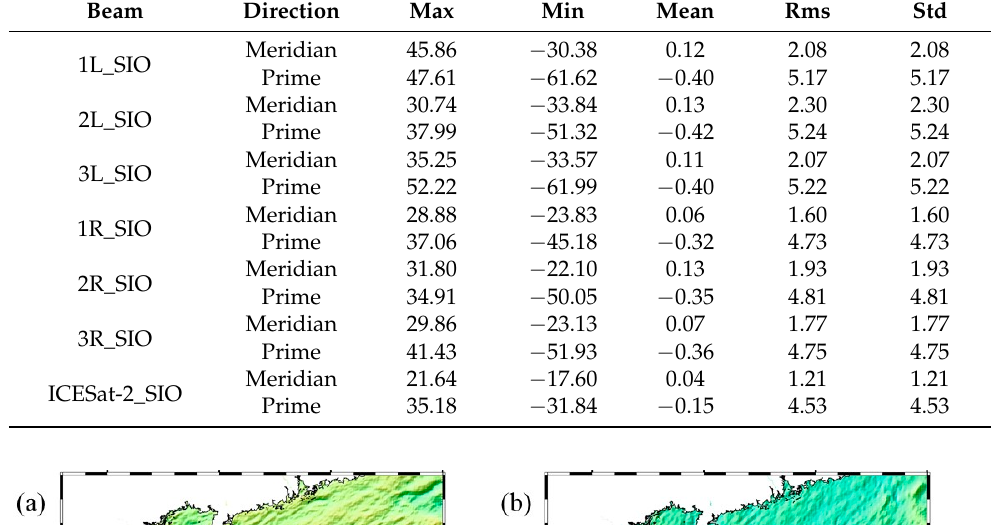
Table 11. Statistics of differences between gridded DOVs calculated by the along-beam DOVs and the SIO V31.1-DOV model (Unit: arc_sec). Beam der a search radius of 8 ′ . Therefore, the optimal search radius is selected as 8 ′ . Table 9. STD of differences between gridded DOVs calculated by the along-beam DOVs with dif- ferent search radii and the SIO V31.1_DOV model (Unit: arc_sec). Search Radius Meridian ICESat-2_SIO-DOV The 2 ′ × 2 ′ gridded DOV within the SCS is derived with the weighted least squares method from along-beam DOVs, and its directional components are shown in Figure 7. The XGM2019e_2159-DOV model and SIO V31.1-DOV model are used to verify the pre- cision of the above gridded DOV. The results are shown in Tables 10 and 11.